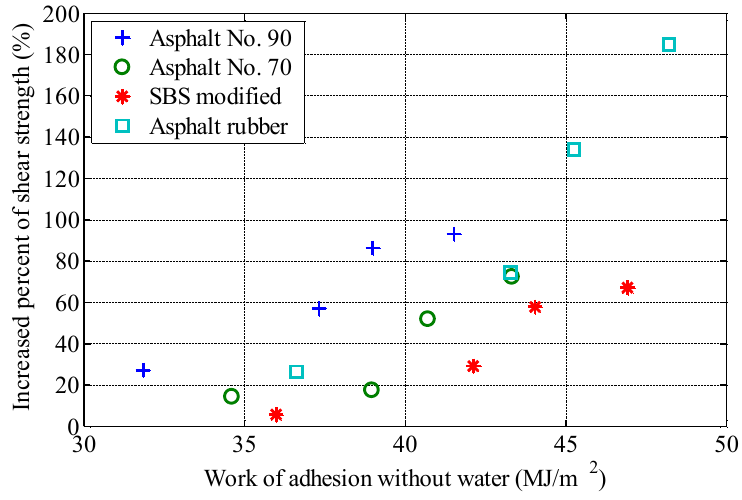
Figure 7. Relationship between work of adhesion and increase percent of shear strength.